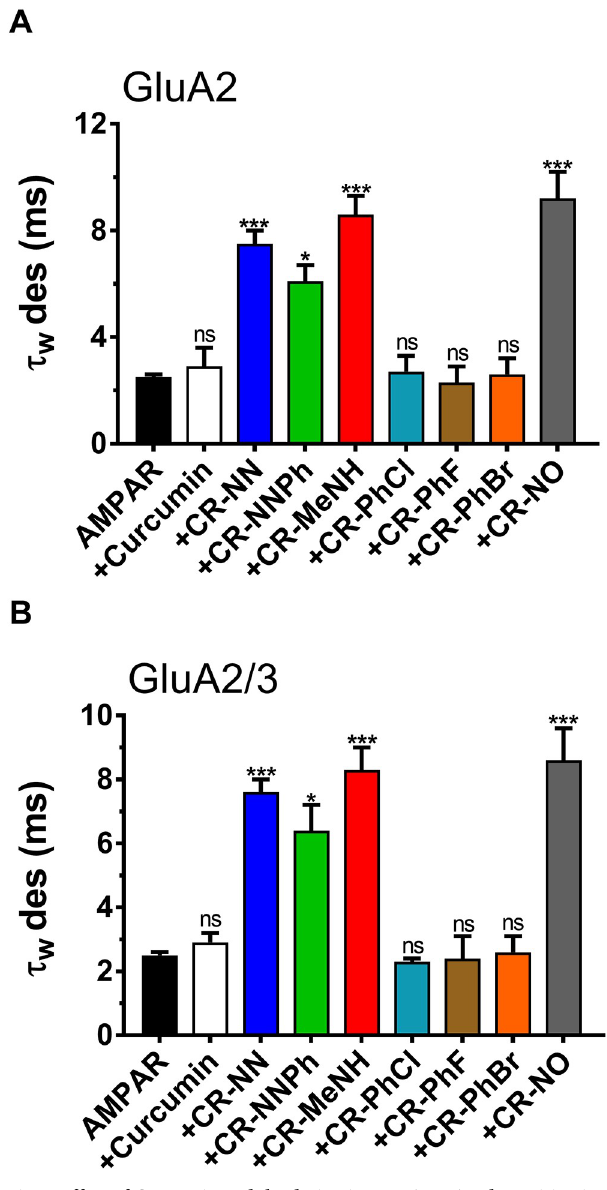
Fig 3. Effect of Curcumin and the derivatives on AMPAR desensitization. A is the desensitization time in milliseconds (ms) from HEK293 cells expressing homomeric GluA2 alone or in combination with derivatives. B is the desensitization time in milliseconds (ms) from HEK293 cells expressing heteromeric GluA2/3 alone or in combination with derivatives. The whole-cell current recording was conducted at − 60 mV, pH 7.4, and 22 ˚C. Graphs summarize weighted time constants for desensitization ( τ W des). Data shown are mean ± SEM; n = 6 (number of patch cells in the whole-cell configuration). Significance (one-way ANOVA): � p < 0.05; �� p < 0.01; ��� p < 0.001; ns, not significant.